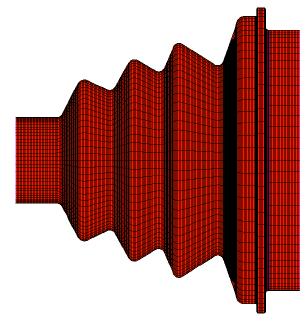
Figure 1: The stress plot for NBR rubber. Figure 2: The 3D discrete model of the rubber